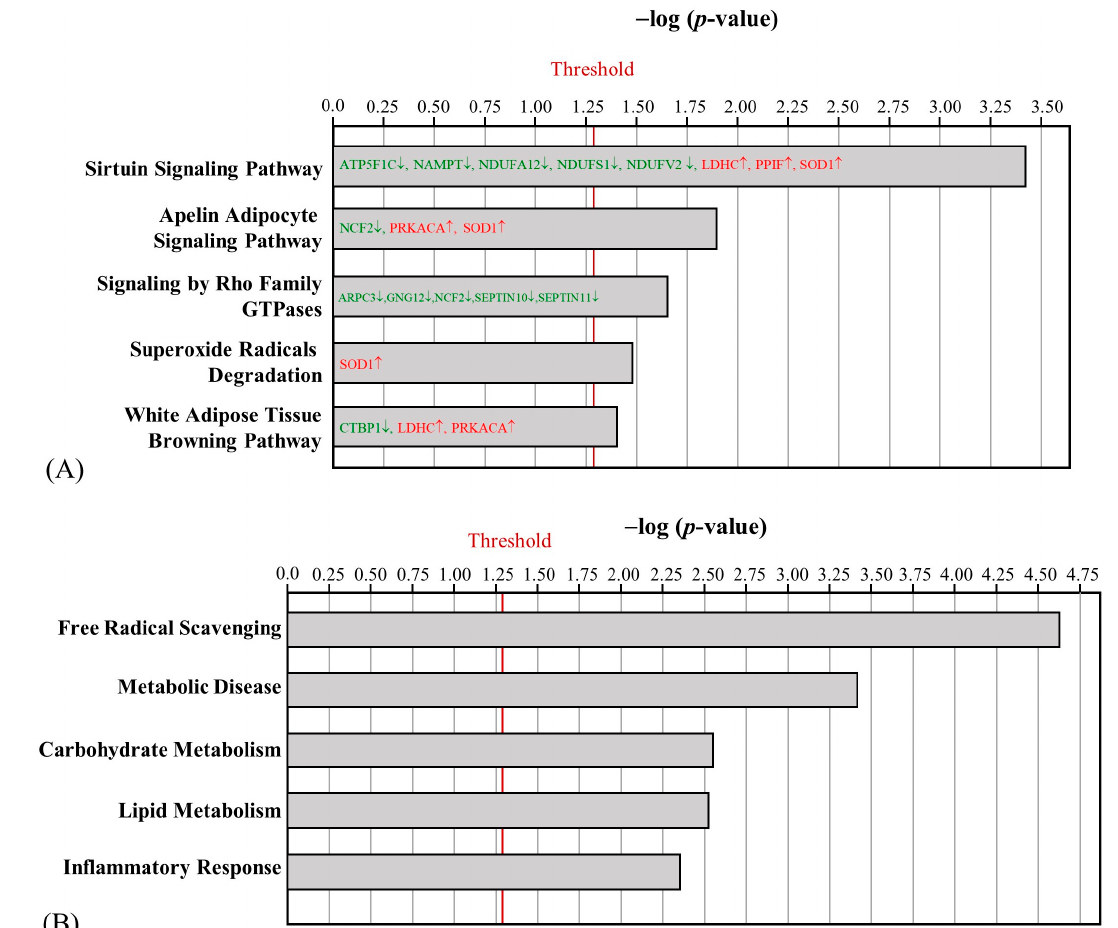
Figure 6. Effect of AE on the canonical pathways ( A ) and biofunctions ( B ) regulated by EFP proteins between the HFD and AE groups. (The proteins with red letters were upregulated, whereas those with green letters were downregulated).